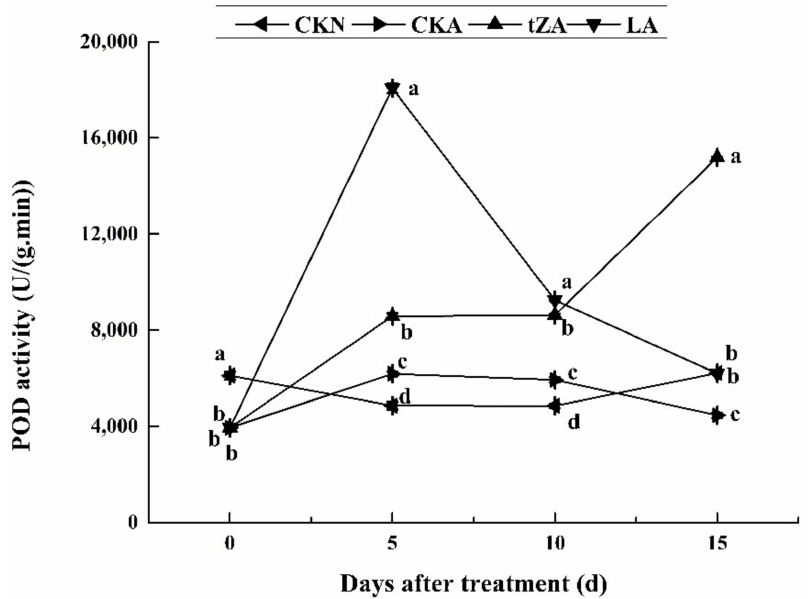
Figure 9. The changes of POD activity in CKN, CKA, tZA and LA groups after the treatment. Different lower-case letters among different treatment groups indicate significant differences based on one-way analysis of variance in SPSS 21.0 followed by the Duncan’s test ( p < 0.05). As shown in Figure 10, the expression of various POD related genes (F01_i1_LQ_F01| c13651/f1p1/1333, F01_i1_LQ_F01|c5575/f1p19/1450, F01_i1_LQ_F01|c8178/f1p1/1241 and F01_i1_LQ_F01|c2634/f1p0/1258) showed a similar trend in CKA and LA groups, which increased initially and then decreased slowly. Their expression increased rapidly in the LA group and showed an average 2.3-fold increase per gene compared with those of the CKA group during the second period (the 5th day after the treatment), which was consistent with the alteration trend of POD activity in the LA group. The expression level of POD-related genes in the tZA group increased during the development of the small seeds, and it was significantly higher than that in the CKA, LA and CKN groups at 15 days after the treatment. The expression level of F01_i1_LQ_F01|c13651/f1p1/1333, F01_i1_LQ_F01|c5575/f1p19/1450, F01_i1_LQ_F01|c8178/f1p1/1241 and F01_i1_LQ_F01| c2634/f1p0/1258 increased 2.0, 18.4, 1.7 and 75-fold compared with those of the CKA group,